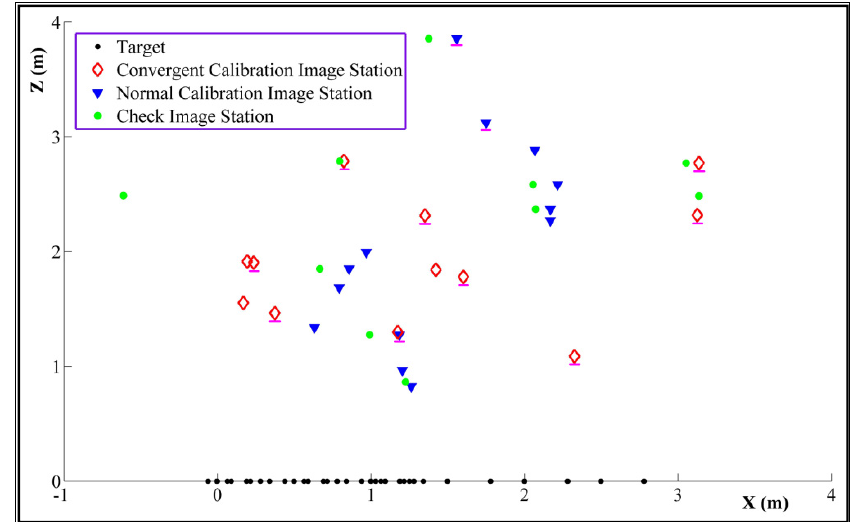
Figure 5. The self-calibration network and check images for independent accuracy